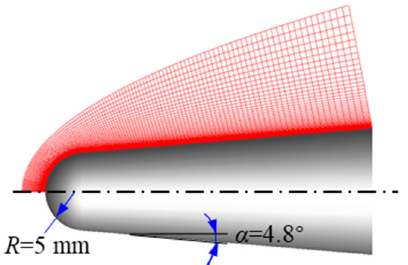
Figure 5. Computational domain and grid of blunt body.